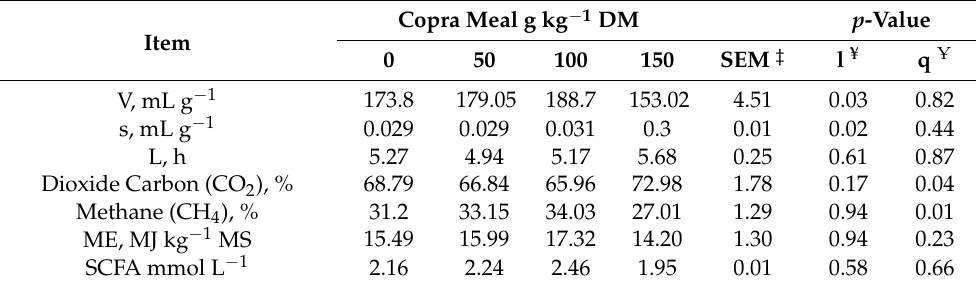
Table 3. In vitro gas production kinetics for feed with different levels of copra